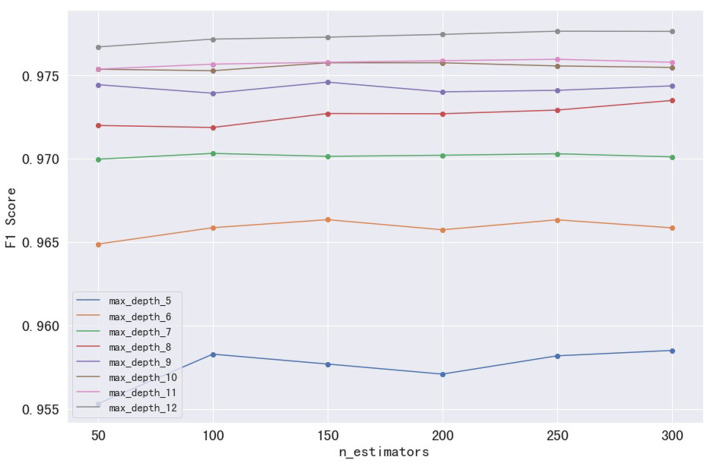
n_ parameter adjustment of estimators.